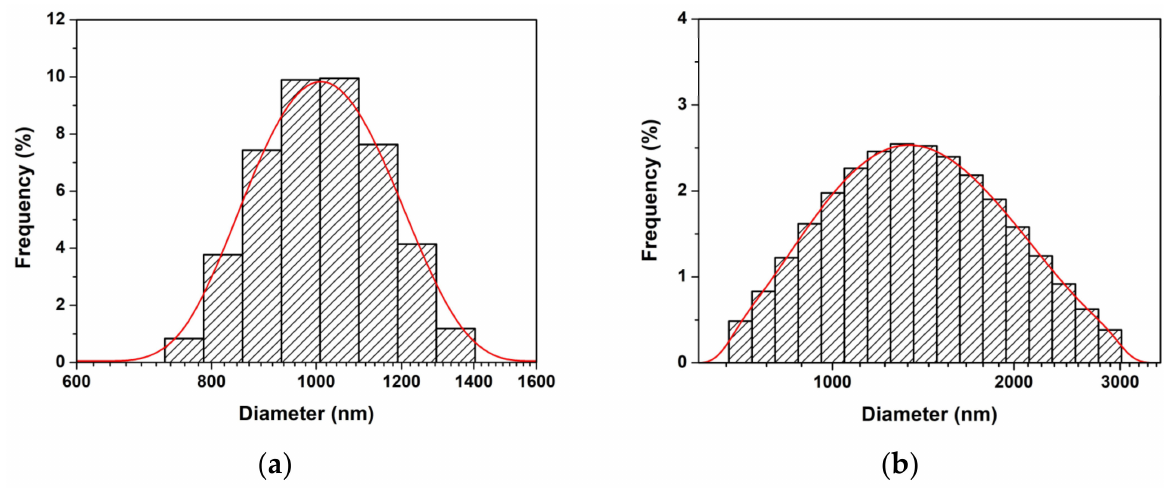
Figure 4. Hydrodynamic diameter of aggregates of ZnO NPs prepared by ( a ) precipitation and ( b ) combustion.